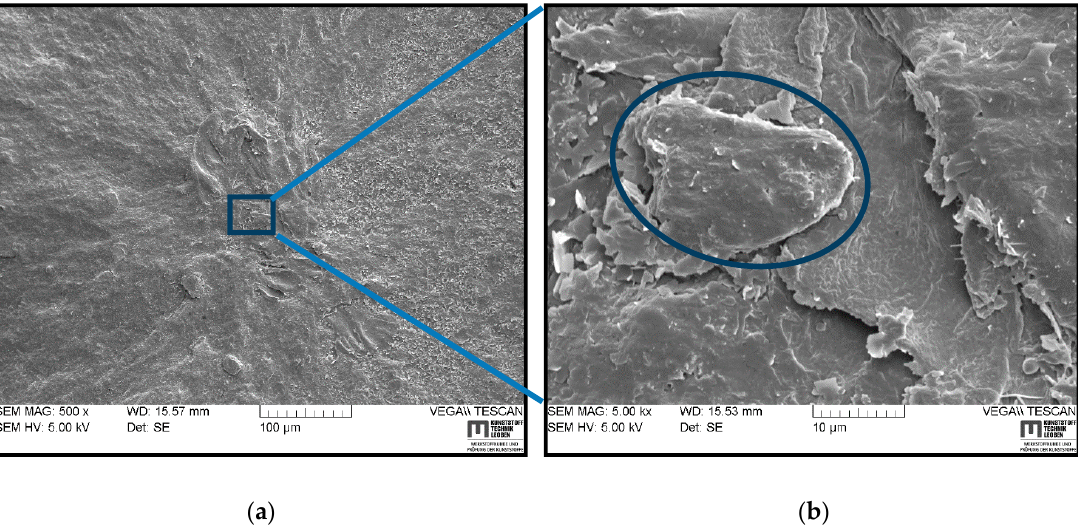
Figure 7. SEM images of a typical fracture surface of HNBR2 in different magnifications: ( a ) fracture initiation and propagation; ( b ) magnified view of fracture initiation from a low strength site.